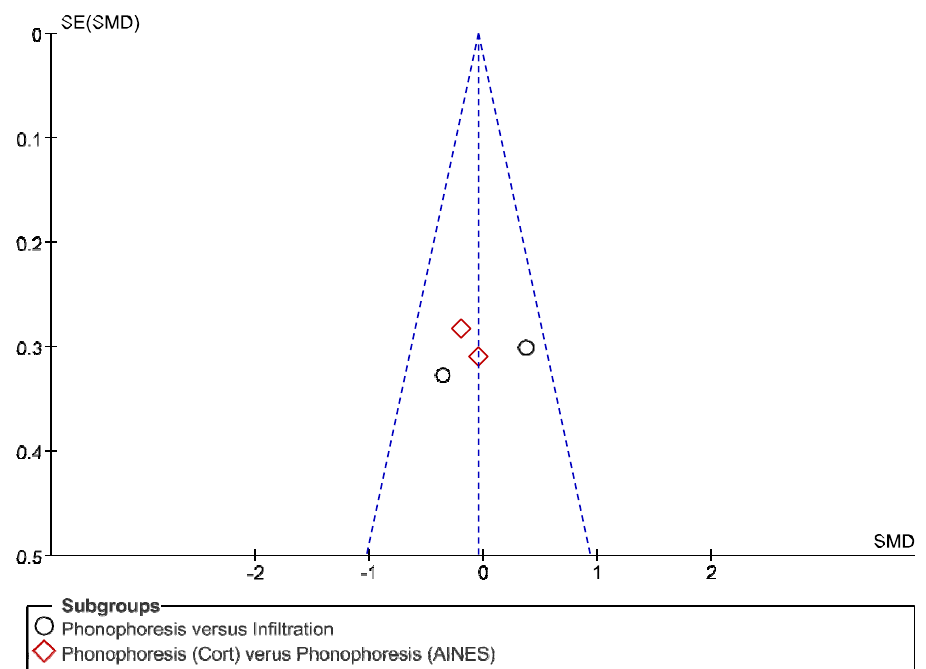
Figure 21. Phonophoresis for SNAPam.